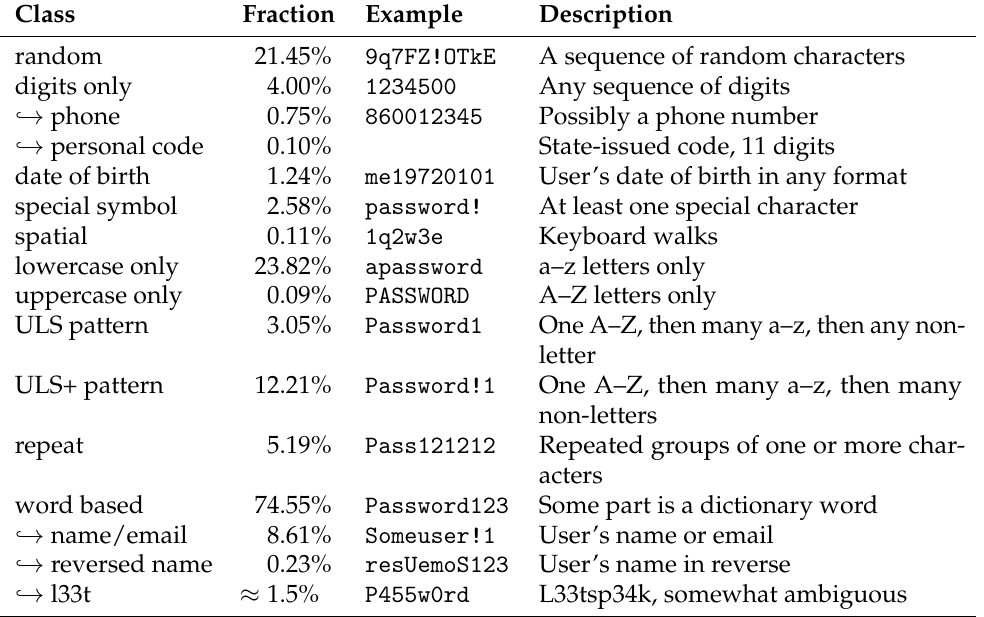
Table 3. Pattern frequency of 102,120 recovered passwords (examples do not disclose real